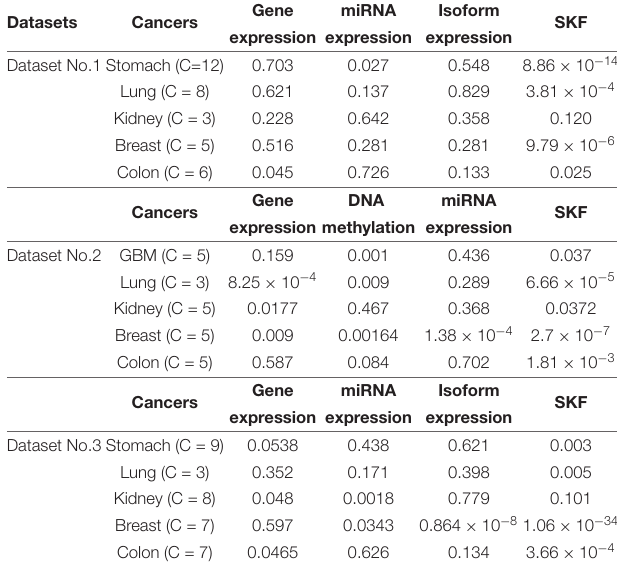
TABLE 2 | Comparison results between SKF and single kernel on three